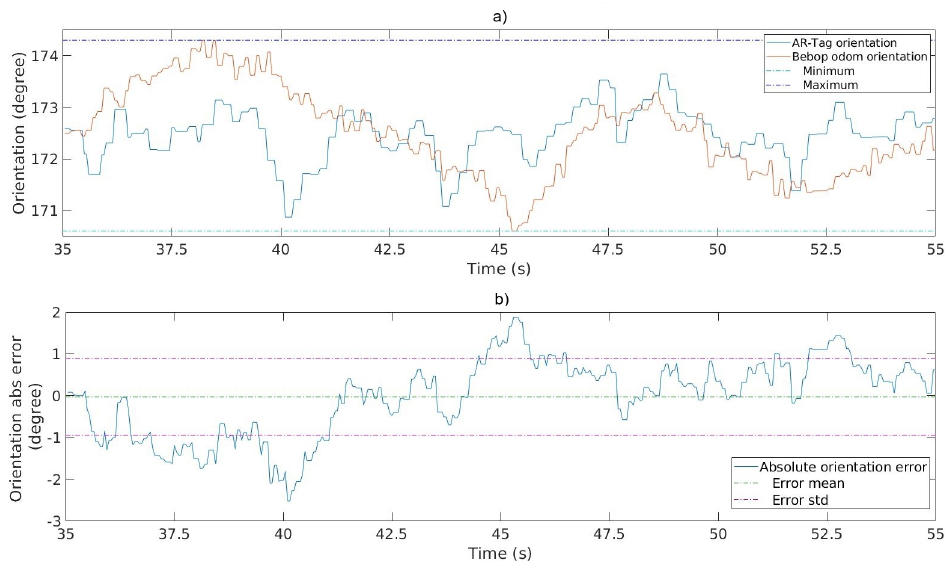
Figure 11. Horizontal orientation estimation. ( a ) AR-Tag vs. Bebop odometry orientation. ( b ) Absolute Bebop vs. AR-Tag orientation error.